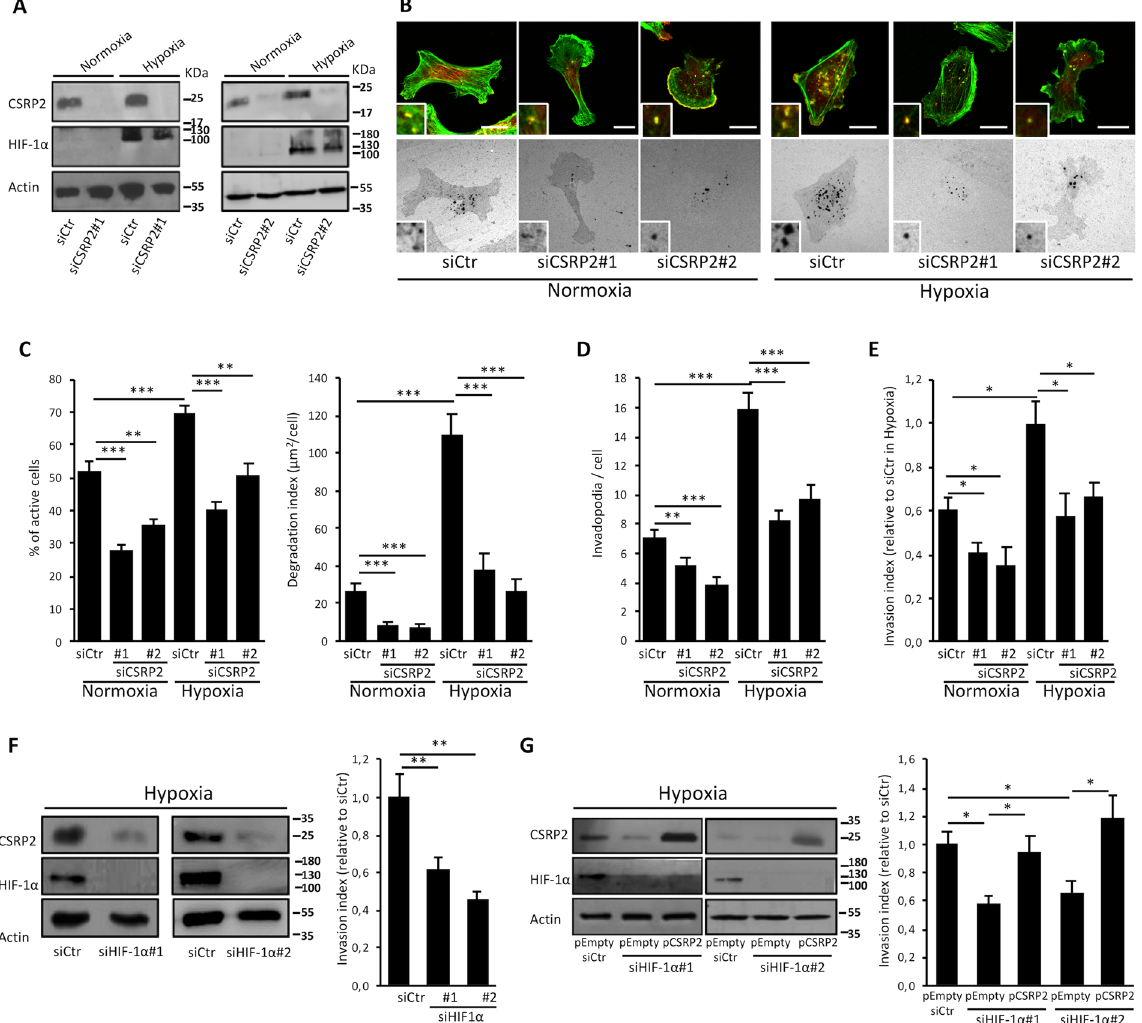
Figure 3. Hypoxia-dependent stimulation of MDA-MB-231 cell invasive potential is mediated by CSRP2. ( A ) Western blot analysis of CSRP2 and HIF-1 α protein levels in MDA-MB-231 cells transfected with non- targeting (siCtr) or 2 different CSRP2-targeting (siCSRP2#1 and 2) siRNAs and cultured under normoxia or hypoxia. ( B ) Gelatin degradation assay. Control and CSRP2 depleted cells were plated on Oregon Green 488-labelled gelatin-coated coverslips for 16 hours, fixed and stained for actin (green) and cortactin (red, upper panels). ( C , D ) Quantitative analyses corresponding to experiments shown in ( B ) with actively ECM degrading cells as expressed as percentage of the total cell population ( C ) left panel), degradation index (average of degraded matrix per cell; ( C ) right panel) and the number of mature invadopodia per cell (F-actin and cortactin co-labelled puncta overlapping with areas of gelatin clearing; D ). The data originate from at least three independent experiments (n ≥ 60 cells). ( E ) Transwell invasion assay. Invading control and CSRP2 depleted cells in normoxia and hypoxia at 24 h were quantified via MTT staining. Results were expressed relatively to the invasion of siCtr-transfected hypoxic cells (set to 1). The data originate from 3 independent experiments. ( F ) Transwell invasion assay with hypoxic MDA-MB-231 cells transfected with control (siCtr) or HIF-1 α (siHIF-1 α #1 and #2) targeting siRNAs. CSPR2 and HIF-1 α protein levels were analysed by western blot (left panel). The data originate from 6 independent experiments. ( G ) Similar transwell invasion assay as in ( F ) with MDA-MB-231 cells that were further transfected with an empty pCDNA3.1 expression plasmid (pEmpty) or a CSRP2 overexpression vector (pCSRP2). Results were expressed relatively to the invasion of siCtr and pEmpty co-transfected cells (set to 1). The data originate from 6 independent experiments. Bars = 15 µ m. * p < 0.05; ** p < 0.01, *** p <